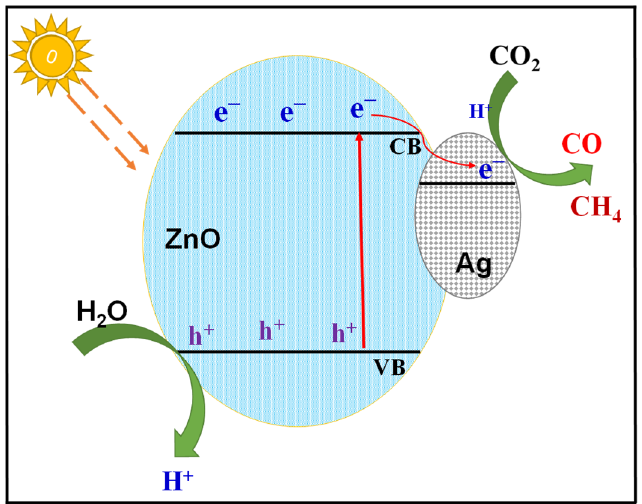
Figure 8. Proposed mechanism for CO 2 conversion into CO and CH 4 by using Ag-ZnO photocatalyst.